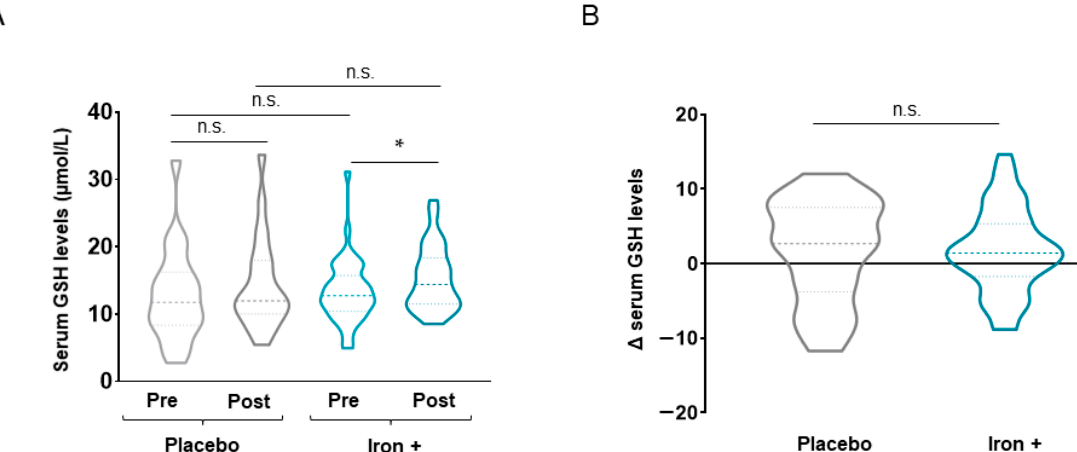
Figure 6. Violin plots of absolute GSH levels in serum of all COPD patient groups ( A ) and delta (post-pre) of serum GSH levels in placebo and iron-treated groups ( B ). The dashed line represents the median and the dotted lines the interquartile ranges. Statistical significance: n.s., no significance; * p < 0.05 between post-iron and pre-iron treatment. Definition of abbreviations: GSH, reduced glutathione.